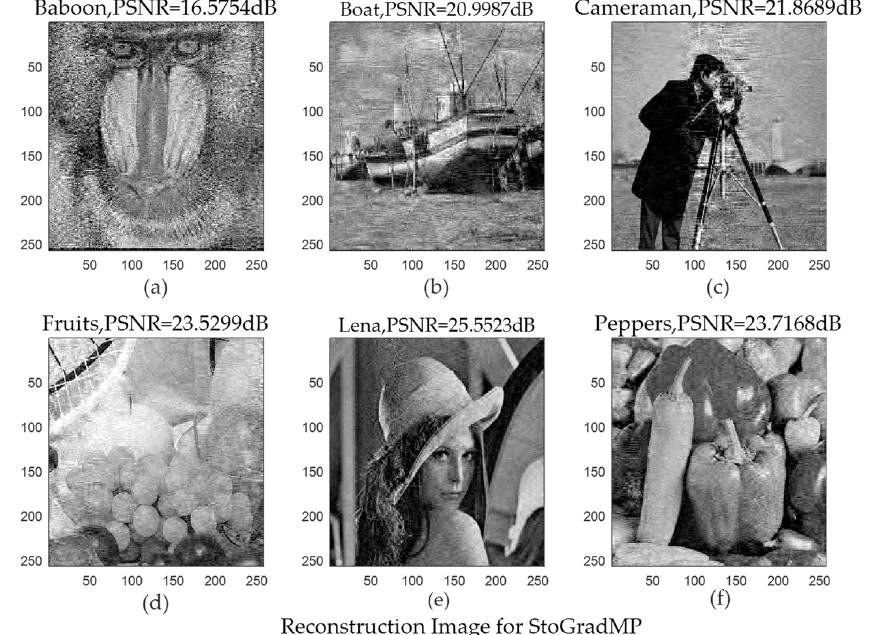
Figure 16. Reconstructed images using the StoGradMP algorithm ( a ) Reconstructed Baboon image with PSNR=16.5754dB; ( b ) Reconstructed Boat image with PSNR=20.9987dB; ( c ) Reconstructed Cameraman image with PSNR=21.8698dB; ( d ) Reconstructed Fruits image with PSNR=23.5299dB; ( e ) Reconstructed Lena image with PSNR=25.5532dB; ( f ) Reconstructed Peppers image with PSNR=23.7168dB.